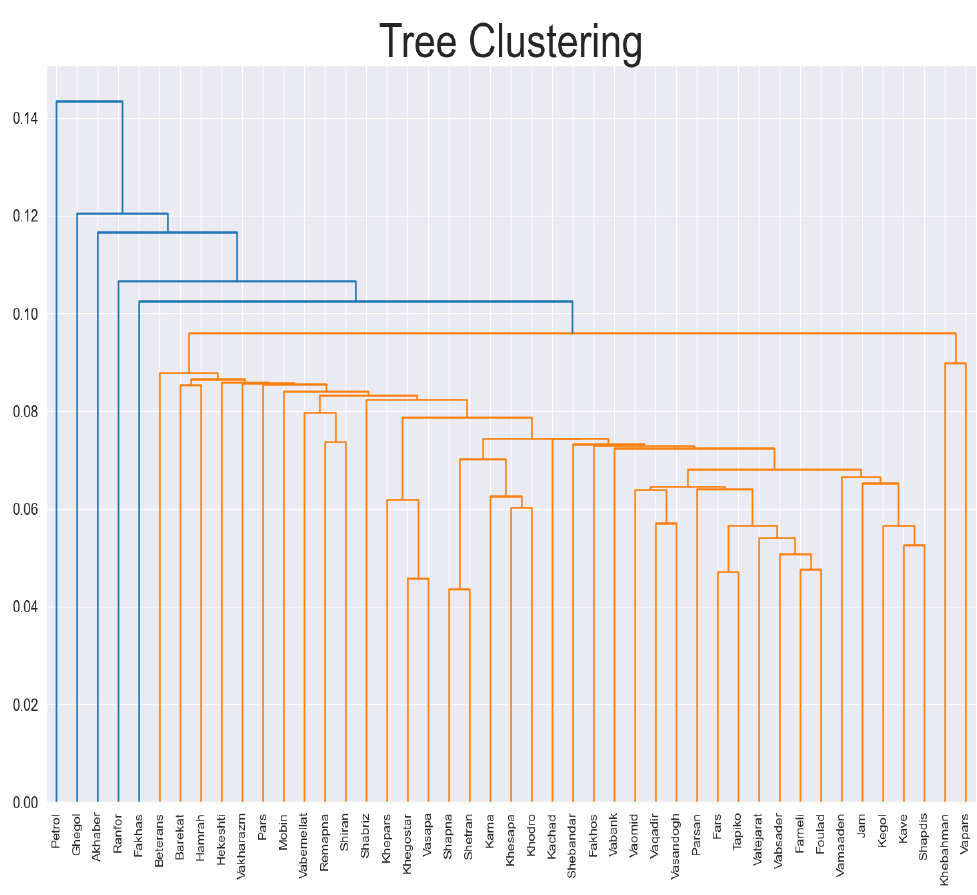
Fig 4. Stock clustering